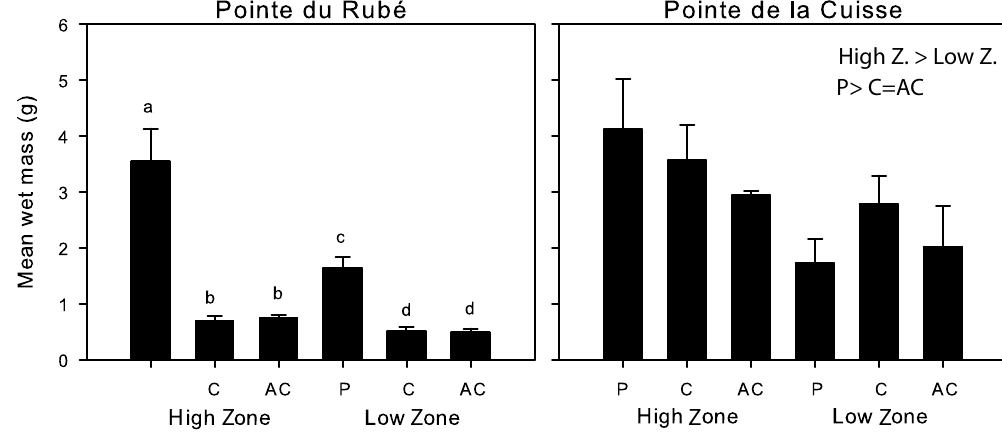
Figure 7. Biomass. Wet weight (g)/12.5 cm 2 (mean plus SE calculated on all plots, n = 4) for each Zone (High and Low) and Treatment in June, at the two sites. P: protected; C: control plots; AC: artefact control. Letters above the bars indicate significant differences of the pairwise-test performed on the interaction TrxZo at Pointe du Rubé (see Table 1 and Supplementary Table S3.1 for more details). At Pointe de la Cuisse, the results of the pairwise tests on the factors Treatment and Zone are reported above the graph (see Table 1 and Supplementary Table S3.2 for more details).